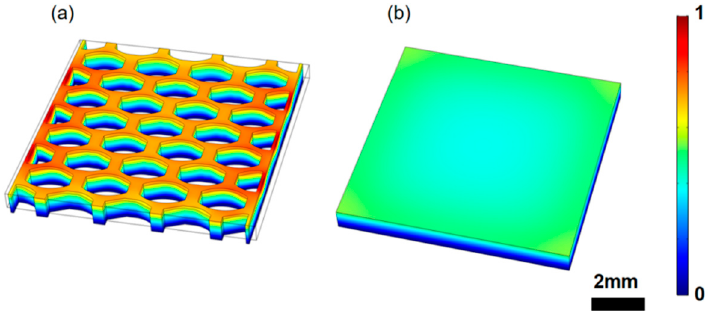
Figure 2. The simulated piezoelectric potential distribution inside the samples with ( a ) honeycomb structure and ( b ) solid brick structure.